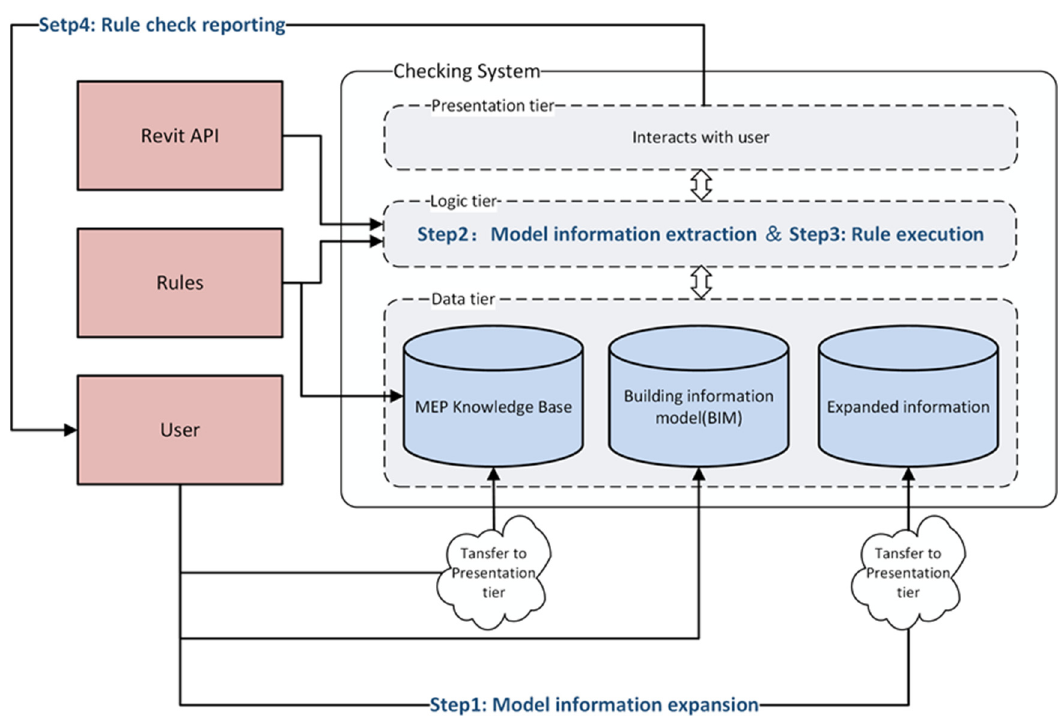
Figure 3. Architecture and implementation of the rule checking system.